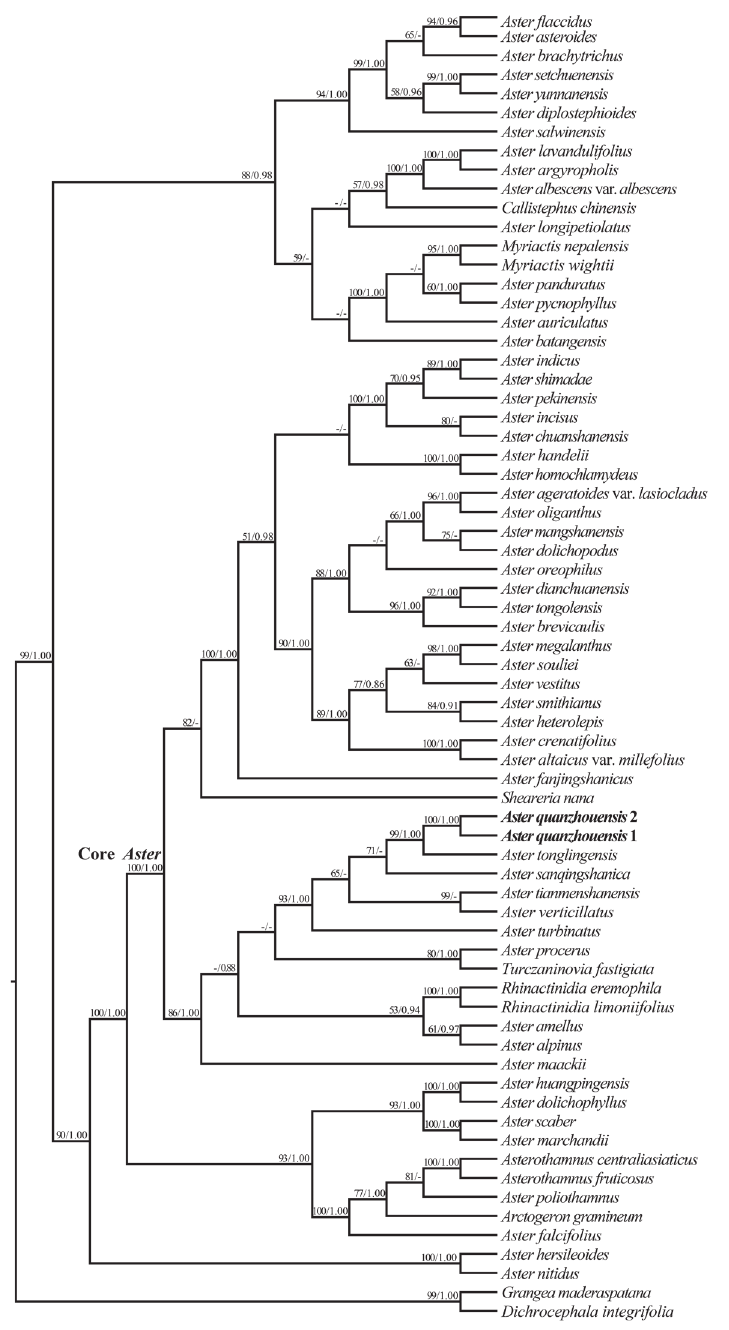
Figure 5. The phylogram of the maximum likelihood (ML) tree from the combined data (ITS, ETS and trnL-F ), showing the phylogenetic position of Aster quanzhouensis . Bootstrap support values (1,000 repli- cates) for maximum parsimony (MP ≥ 50%, left) and Bayesian posterior probabilities (PP ≥ 0.90, right) are provided above the branches. The samples of Aster quanzhouensis are shown in